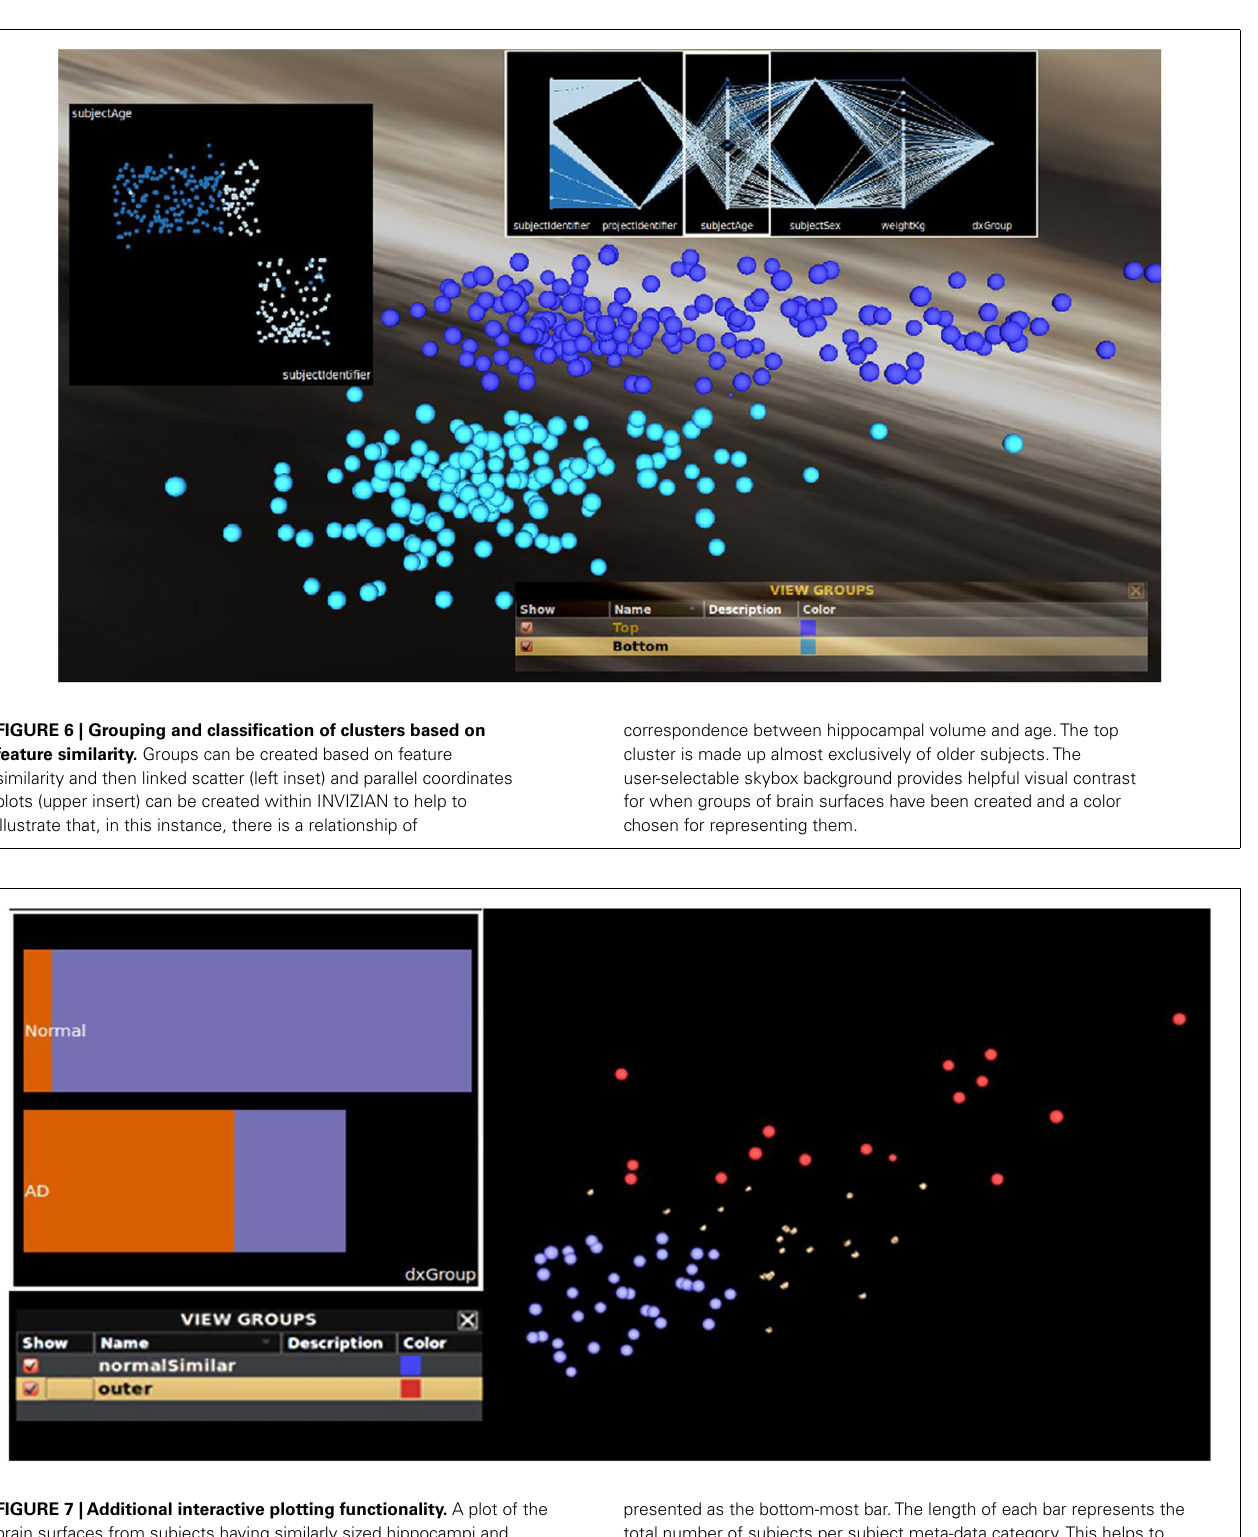
FIGURE 7 |Additional interactive plotting functionality. A plot of the brain surfaces from subjects having similarly sized hippocampi and classified by their meta-data as being “normal” (blue) and subjects with Alzheimer’s disease (red).With these groups selected, a bar chart (inset) plots subject meta-data diagnosis value by feature value. Normal subjects are plotted as the top-most bar and the Alzheimer’s disease (“AD”) group is